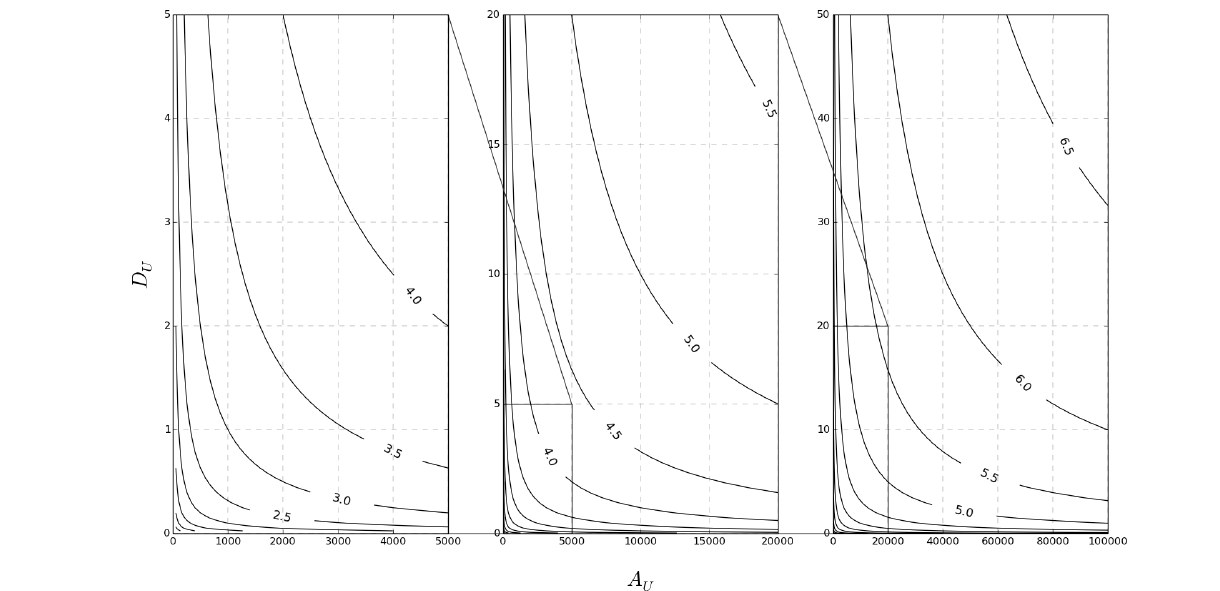
Figure 1. A contour plot illustrating the stability of the app usage factor as a function of Au and Du, including determination of metric limits.